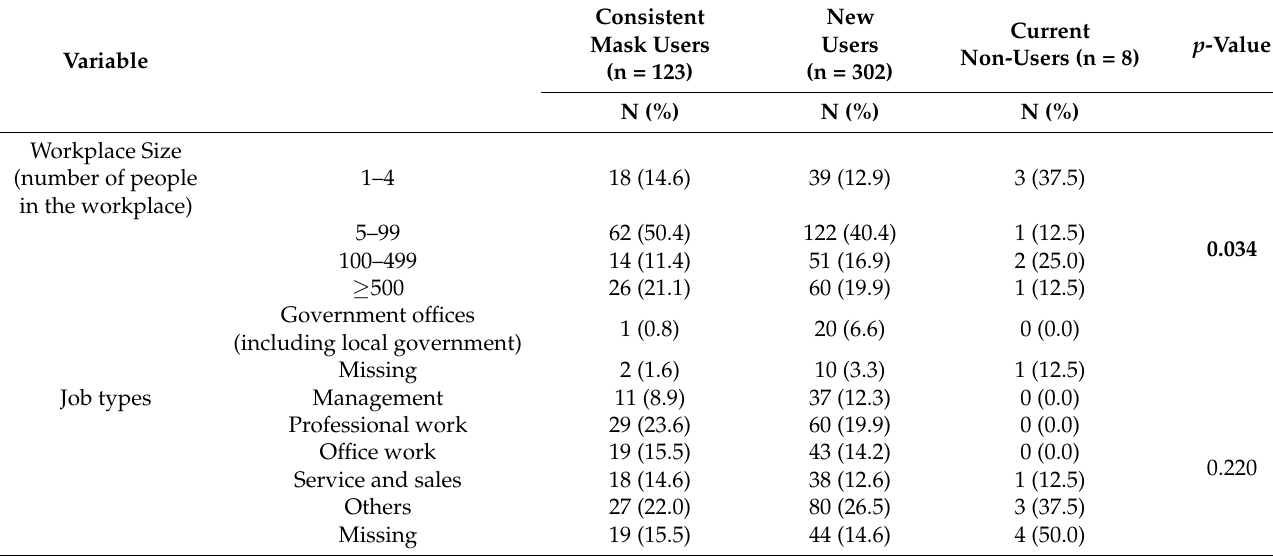
Table 6. Distribution of workplace size and job types by mask use behavior among workers (n = 433) a .